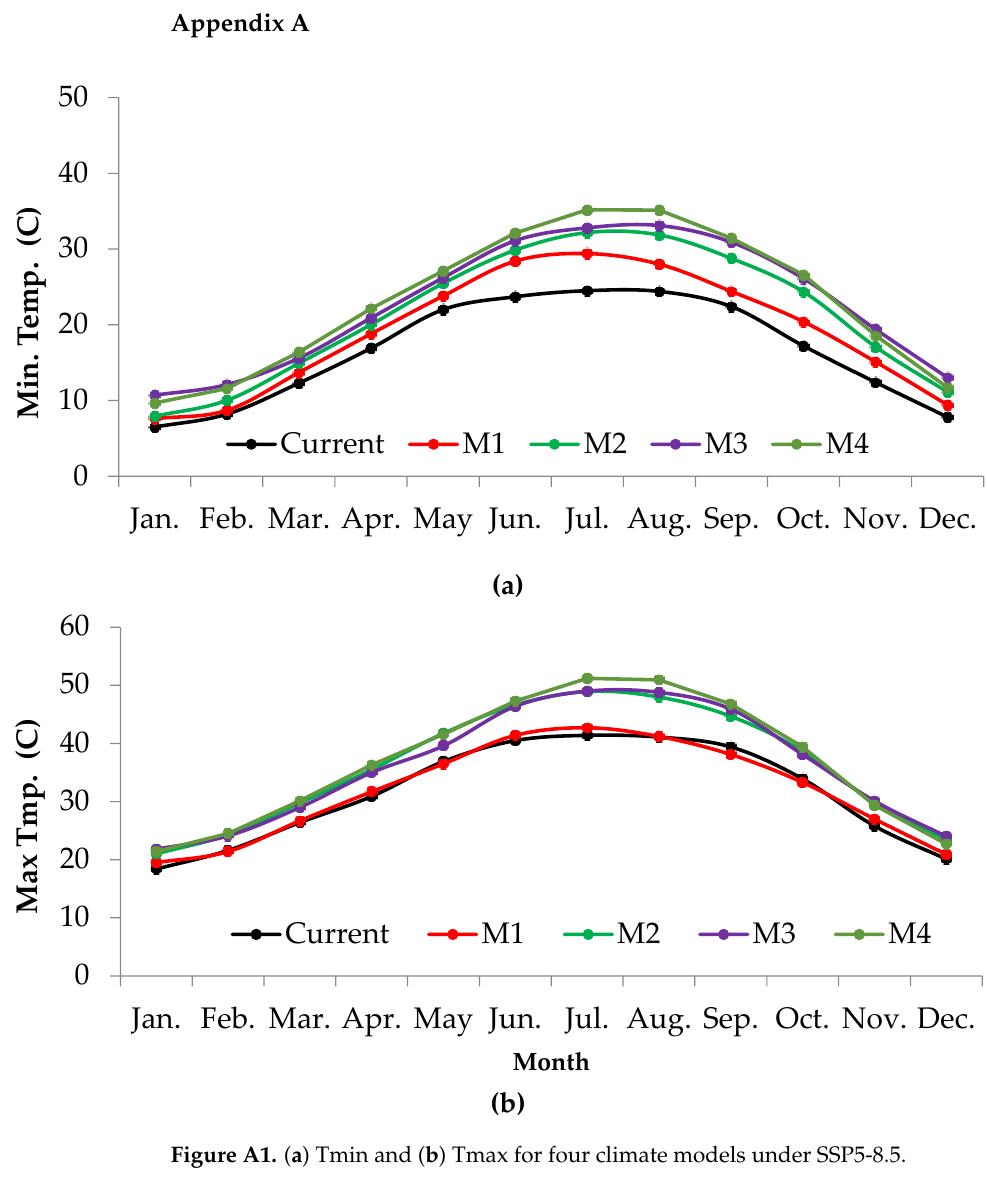
Figure A1. ( a ) Tmin and ( b ) Tmax for four climate models under SSP5-8.5.